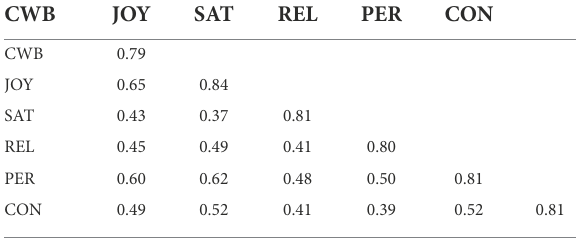
TABLE 2 Scale items and factor